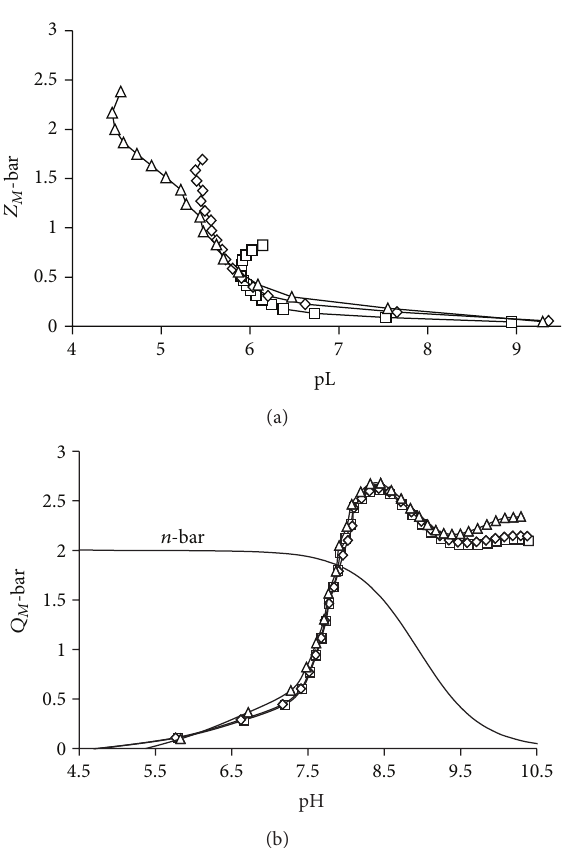
Figure 2: Experimental and theoretical (solid line) (a) formation function and (b) deprotonation function curves for Ni(II)-L1 system at 25 ∘ C and an ionic strength 0.15M (Cl −1 ). M: L ratios 1:1 ( ◻ ), 1: 2 ( ◊ ), and 1: 3 ( Δ ) are displayed. The theoretical line was calculated using model 1 given in Table 1.